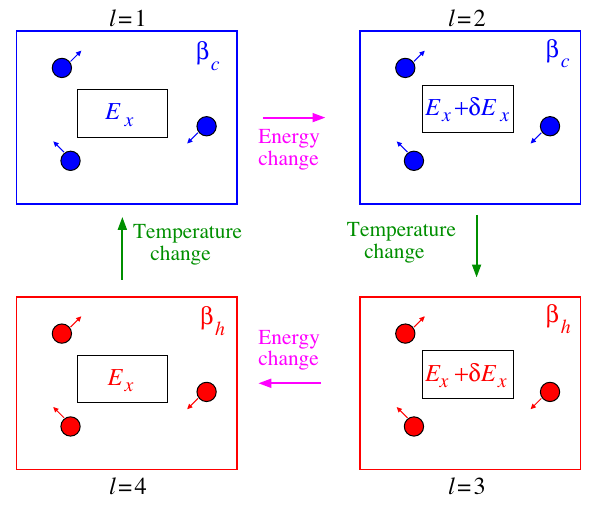
FIG. 4. Depiction of the protocol for the case studies. The inner box represents the observable degree of freedom x and the respective energy E x . The particles with arrows represent hidden active degrees of freedom labeled by a . The four steps are as follows: from l ¼ 1 to l ¼ 2 energy changes from E x to E δ E l ¼ 2 to l ¼ 3 the inverse temperature changes x þ x , from from β c to β h , from l ¼ 3 to l ¼ 4 the energy changes from E δ E E l ¼ 4 to l ¼ 1 the inverse temperature x þ x to x , and from changes from β h to β c